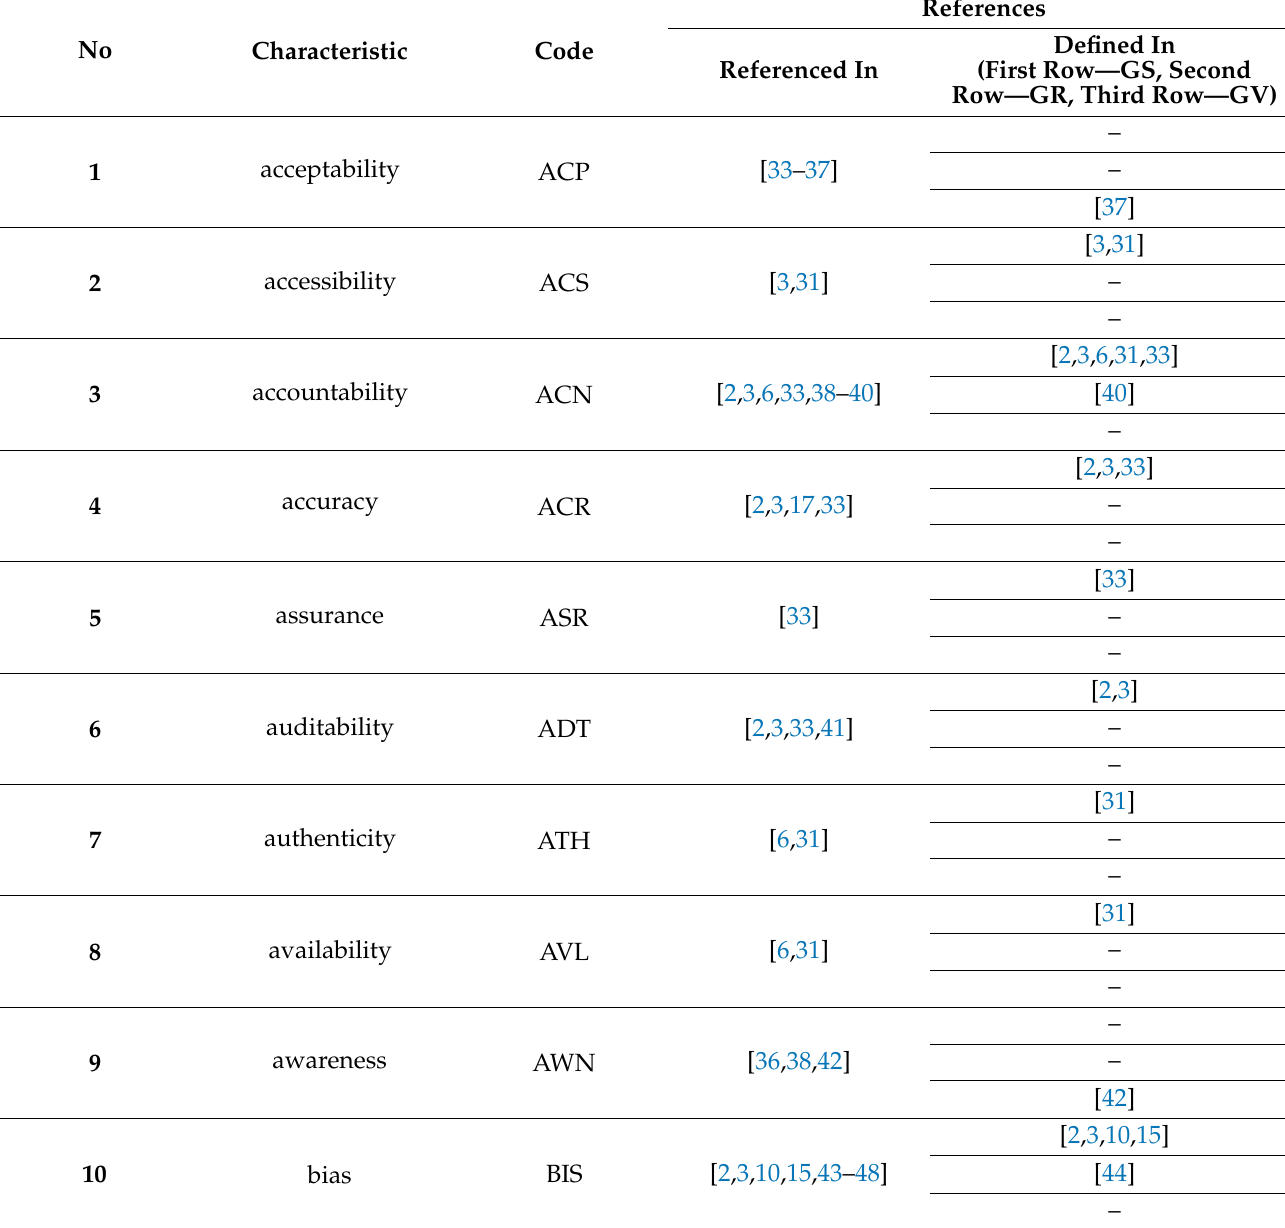
Table 1. AI characteristics